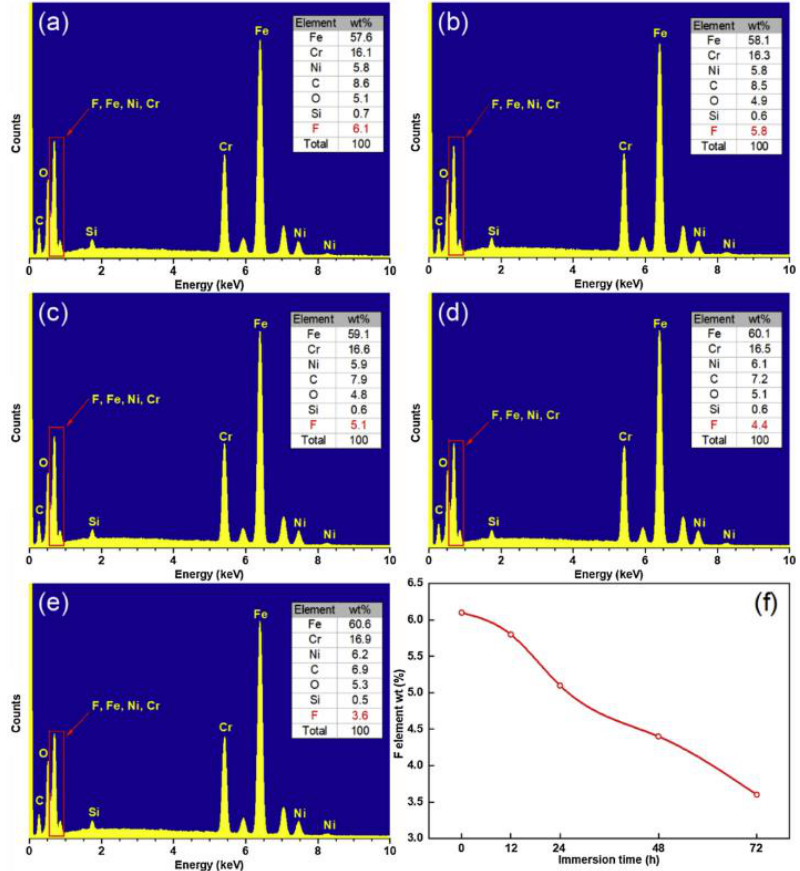
Figure 31. EDS spectrum of superhydrophobic surface prepared after soaking in NaCl solution for: ( a ) 0 h, ( b ) 12 h, ( c ) 24 h, ( d ) 48 h, and ( e ) 72 h. ( f ) The change of fluorine content with soaking time